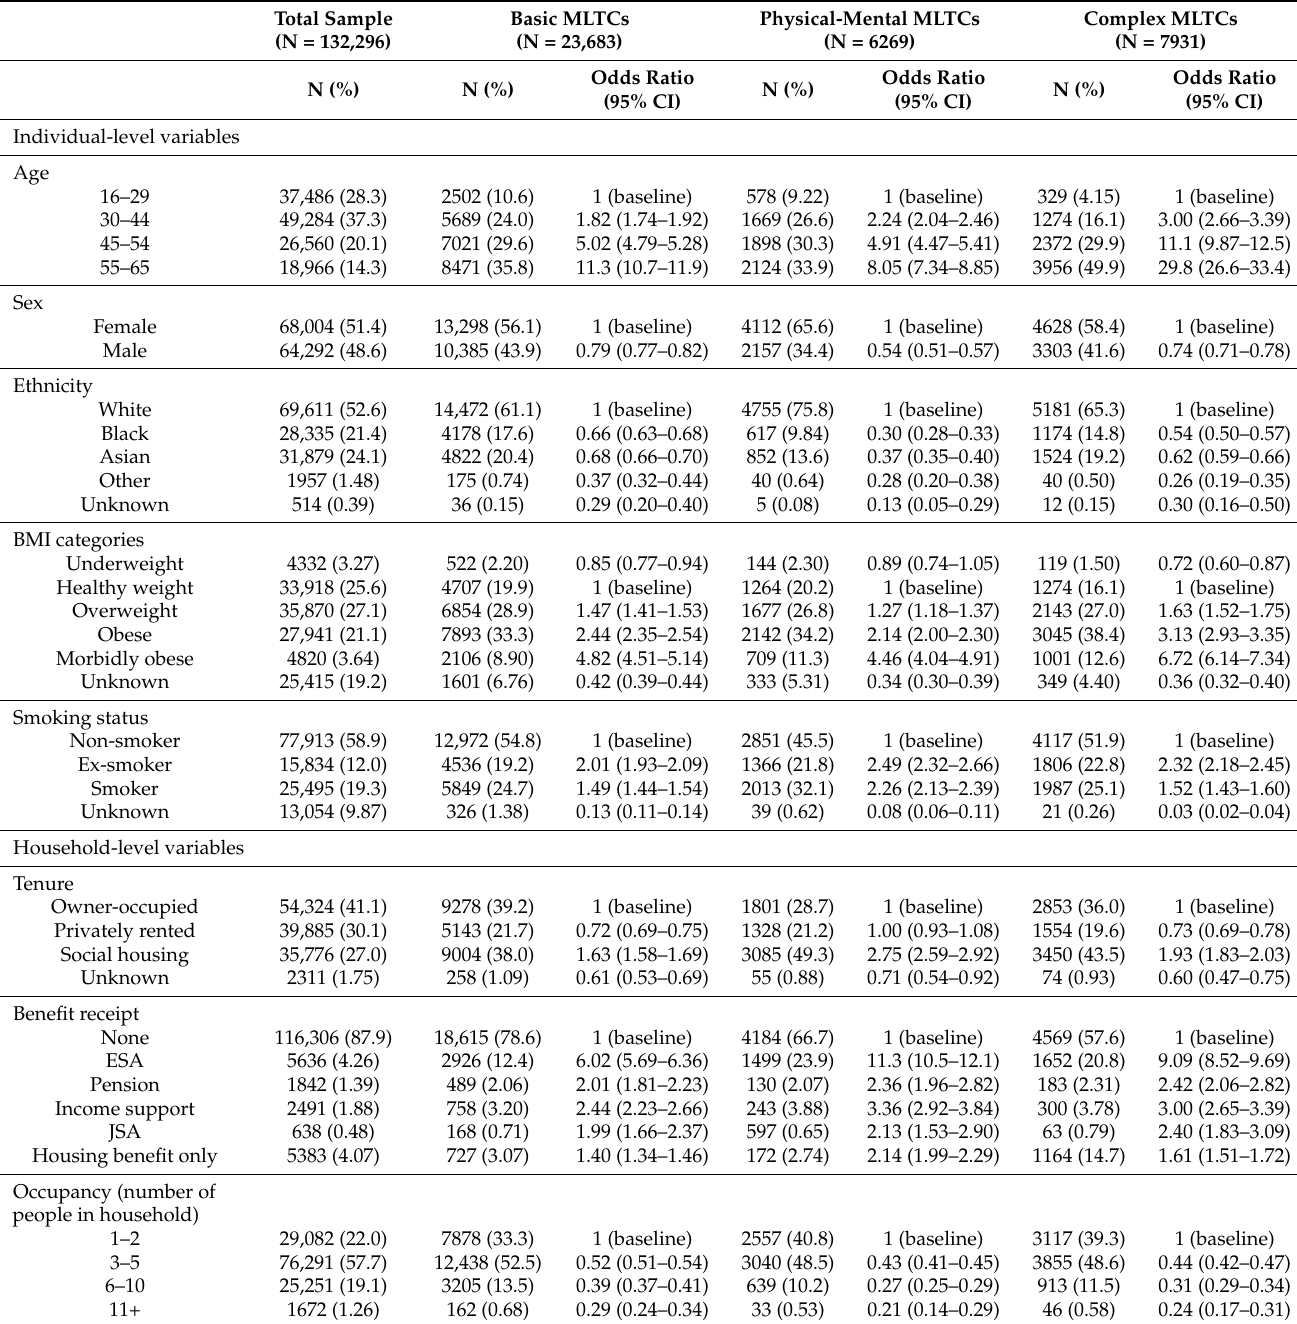
Table 1. Characteristics of study participants (N =